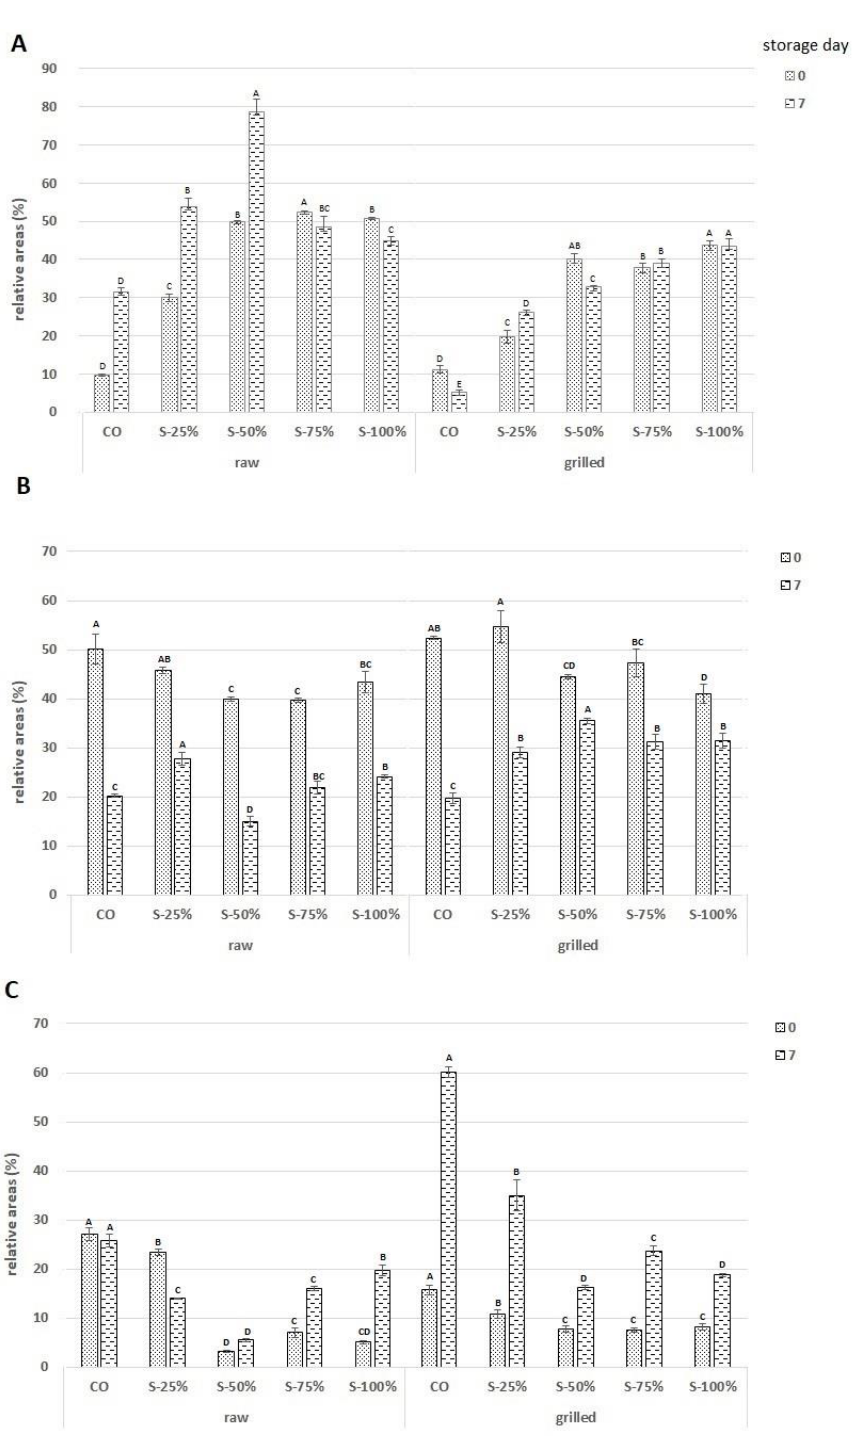
Figure 5. The relative peak areas (%) of the three main groups of volatile compounds: ketones ( A ), alcohols ( B ), and aldehydes ( C ) in beef burgers with substituted fat after 0 and 7 days of storage; CO-control with tallow (0% fat substitute), S-25%, S-50%, S-75%, S-100% means respectively replac- ing beef fat with 25, 50, 75, and 100% substitute. A – D — means with different letters showing a signif- icant effect of the treatment group in the same day of storage, p < 0.05.